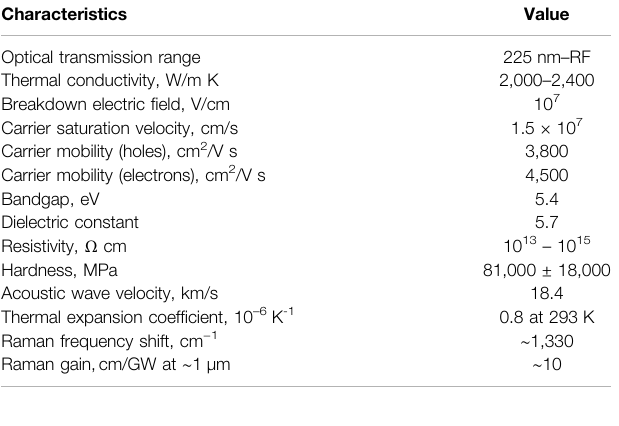
FIGURE 2 | Transmission properties of the CVD diamond sample with varying fl uence and number of laser pulses